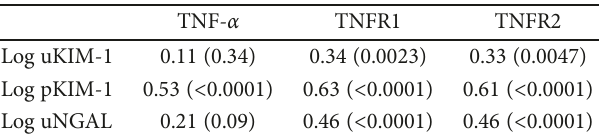
Table 3: Correlation coe ffi cient between TNF-related markers and KIM-1 and NGAL in diabetic African American